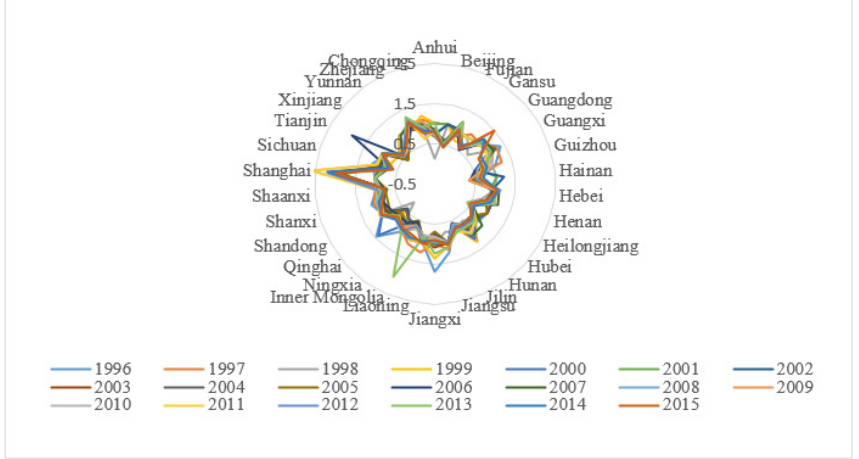
Figure 4. Environmental production efficiency of different provincial administrative regions in China. (Source: Authors compiled).